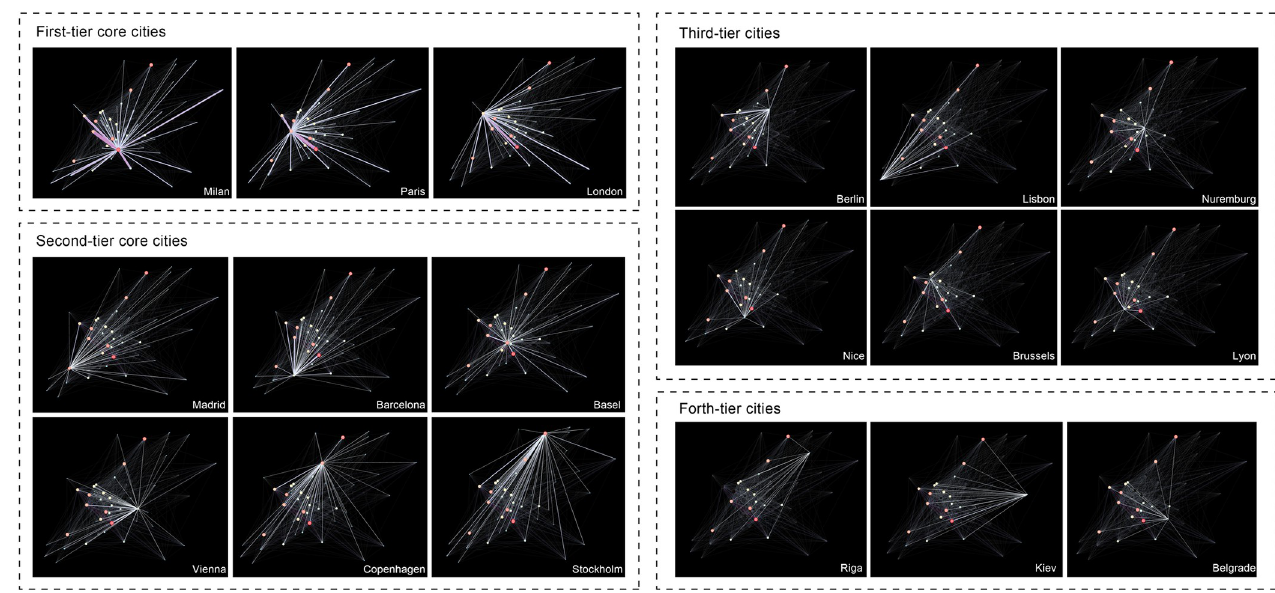
Fig 8. The interlock scope of different tiers.